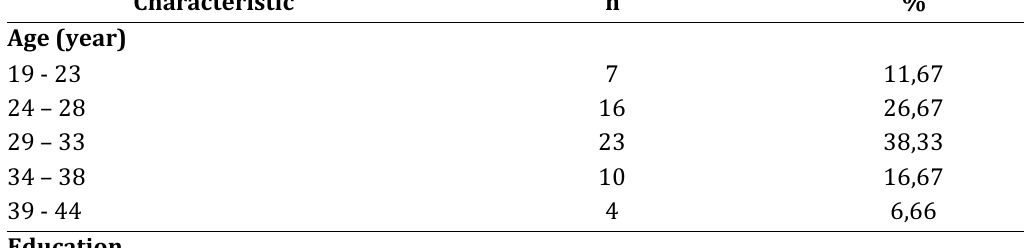
Characteristic respondent that consisted of healthcare professional